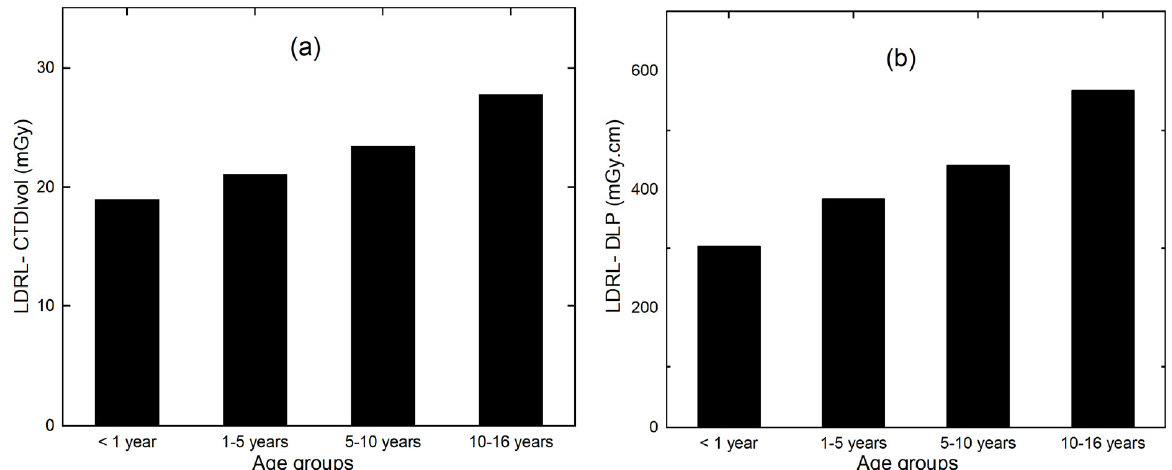
Figure 1. ( a ) Local diagnostic reference level for CTDIvol for pediatric head CT scans and ( b ) local diagnostic reference level for DLP for pediatric head CT scans in the Emirate of Abu Dhabi, UAE.